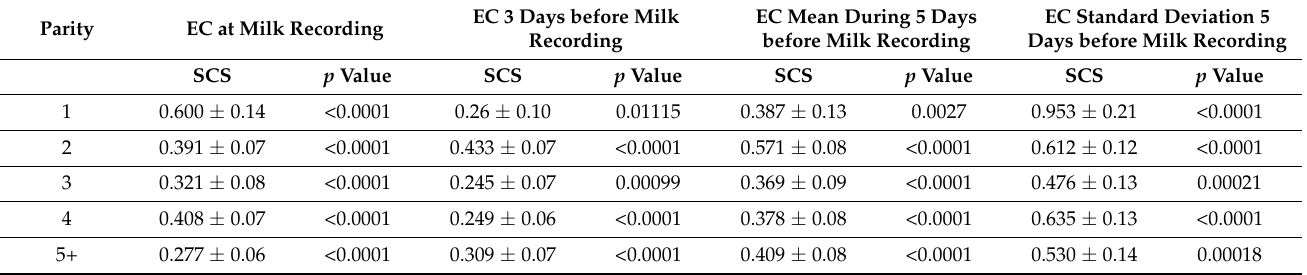
Table 5. Estimated linear regression coefficients of different EC parameters nested within parity for SCS in Italian Mediterranean